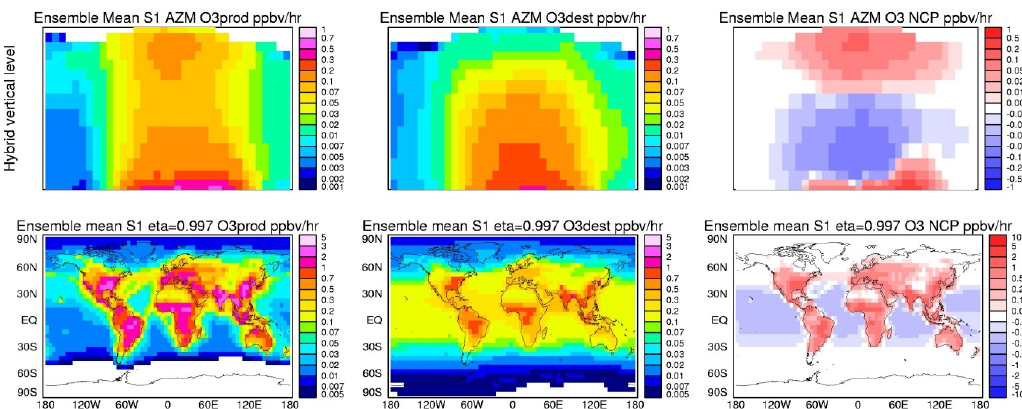
Figure 2. Multi-model mean (20 models) year 2000 ozone budgets (units: ppbh − 1 ). Top row: annual zonal mean (AZM) chemical produc- tion, chemical destruction and net chemical production. Vertical scale is from surface to approximately 100hPa. Bottom row: maps of same quantities in the surface model layer (Stevenson et al.,